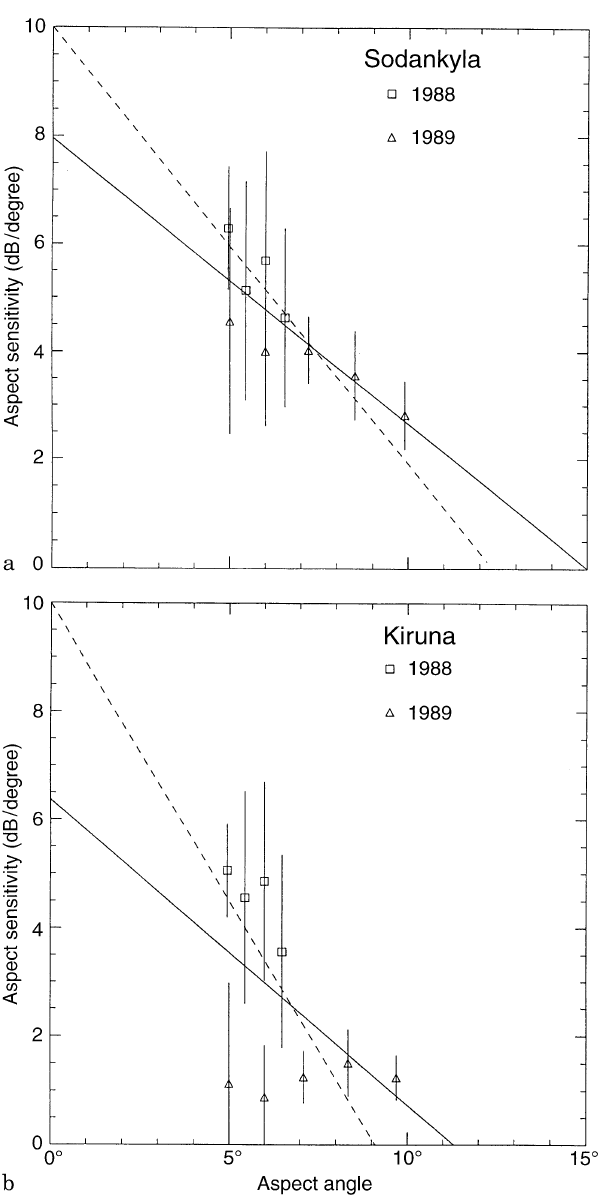
Fig. 3a, b. Estimated aspect sensitivity on the a Troms (cid:249) -Sodankyla¨ and b Troms (cid:249) -Kiruna links. Dashed line is the best fit to CP3C2 data, solid line is best fit to both data sets